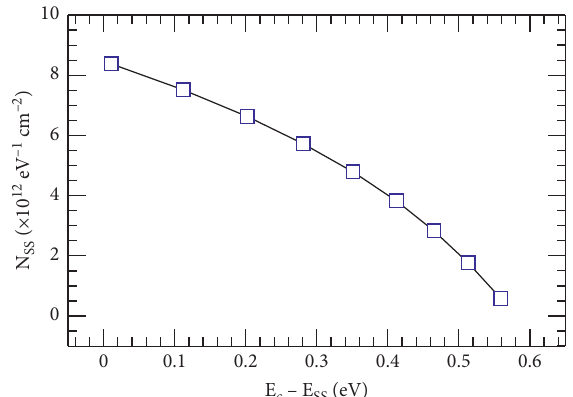
SS ) obtained from I-V